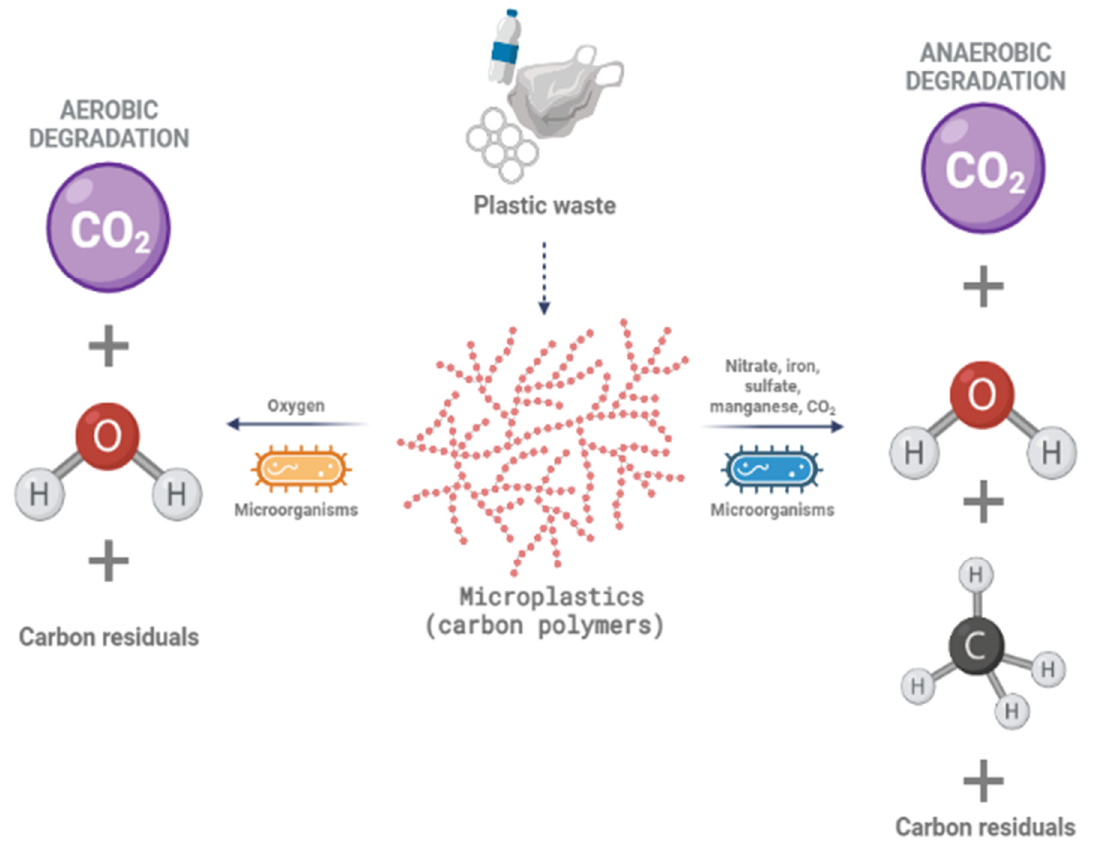
Figure 2. Schematic representation of aerobic and anaerobic decomposition of plastic by microorganisms. The aerobic degradation of MPs by microorganisms leads to their disintegration to CO 2 , H 2 O, and carbon residuals, while in the anaerobic degradation, CO 2 , H 2 O, CH 4 , and carbon residuals are formed. Diagram created in https://biorender.com/ (accessed on 27 July 2022).